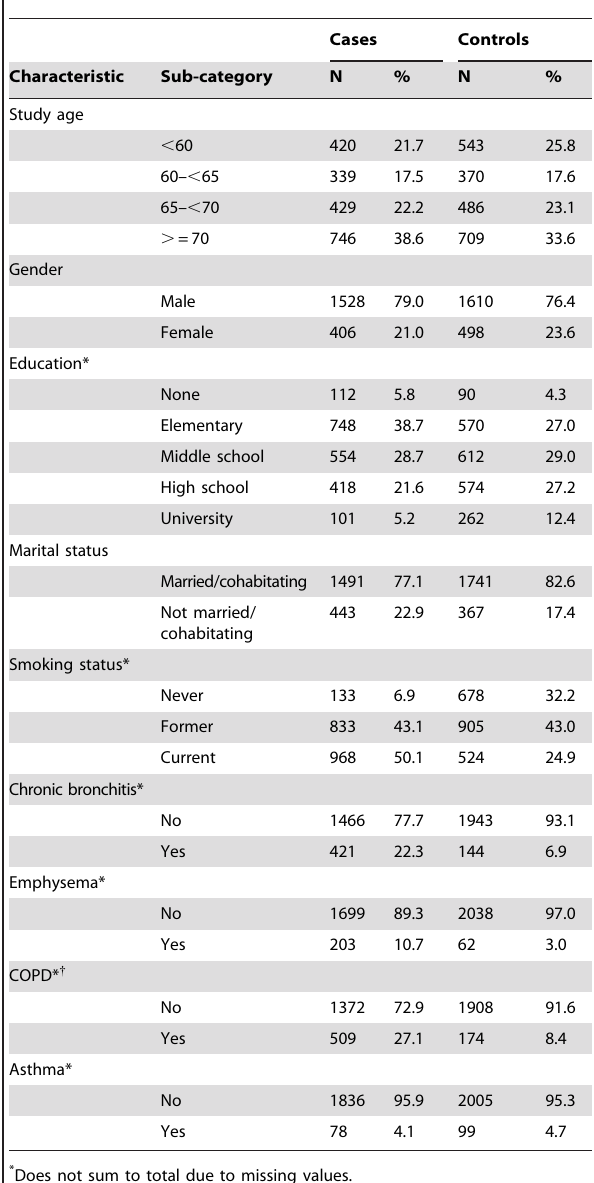
Table 1. Distribution of cases and controls in the Environment And Genetics in Lung cancer Etiology study who provided data on chronic bronchitis, emphysema, or asthma diagnosed at least one year prior to study